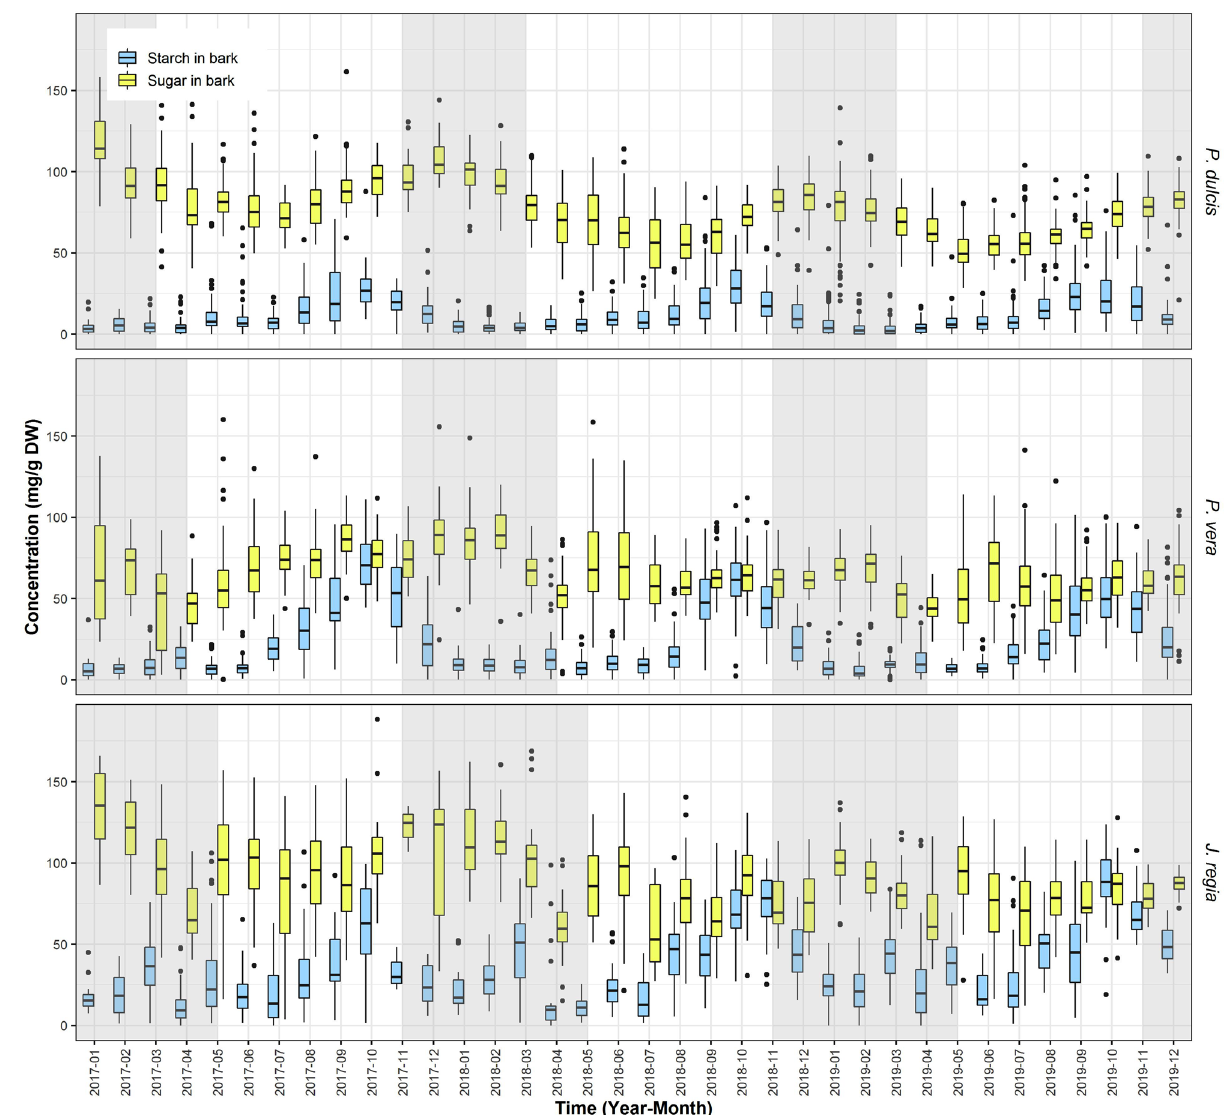
Figure 4. Starch and sugar in bark. Average concentration of starch (blue) and sugar (yellow) in bark from all sites for P. dulcis , P. vera and J. regia from January 2017 to December 2019. The upper whisker extends from the hinge to the largest value no further than 1.5*IQR from the hinge (where IQR is the inter-quartile range, or distance between the first and third quartiles). The lower whisker extends from the hinge to the smallest value at most 1.5*IQR of the hinge. Grey shading reflects the dormancy period of each and similar in all three species. Year-to-year SC content variation in bark was significant in all three species while starch content only varied in J. regia (Table 3). Starch and soluble sugars in wood. Both SC and St content in the wood undergo significant seasonal fluctuation. All three species seemed to follow similar patterns. Highest levels of soluble sugars and starch occurred in the fall and lasted through the winter, while lowest levels of starch and soluble sugars occurred dur- ing spring and early summer (Fig. 5). In P. dulcis SC content varied from 10 to 48 mg/g DW and St content varied from 3.5 to 48 mg/g DW, in P. vera SC content varied from 19 to 57 mg/g DW while St content varied from 4 to 92 mg/g DW, and in J. regia SC content varied from 19 to 76 mg/g DW with St varying from 3 to 50 mg/g DW. In general, starch provides a much higher contribution to NSC content in wood than in bark and in P. vera and P. dulcis wood starch is the dominant form of NSC reserves during winter. Year-to-year variation was highly significant in the wood only for soluble sugars in P. vera and P. dulcis and non-variable in J. regia . Starch content, on the other hand, remained very invariable between years in P. dulcis and P. vera , but was significantly different for several months in J. regia (Table 3).